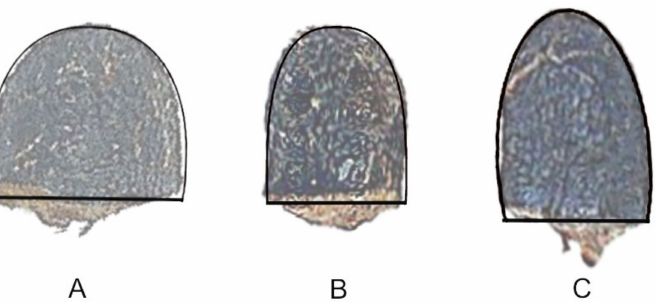
Figure 1. Seedsof Rebutiaheliosa ( A ), R.pseudodeminuta ( B )and R.fiebrigii ( C )withtheirmodelssuperimposed.